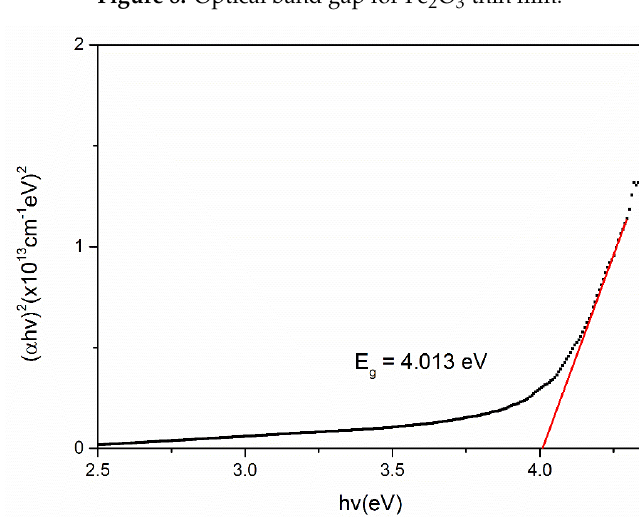
Figure 8. Optical band gap for Fe 2 O 3 thin film.